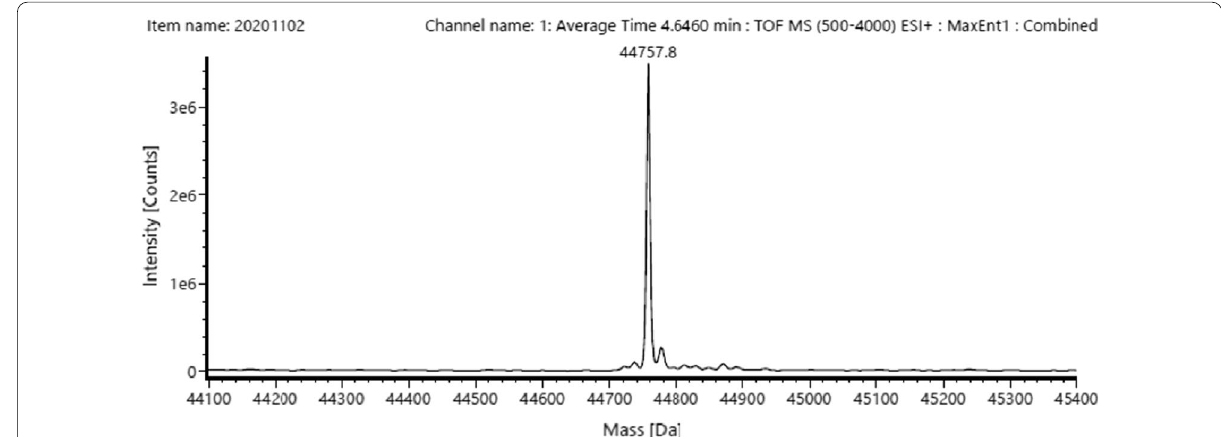
Fig. 1 Mass spectrometry analysis of rhCol